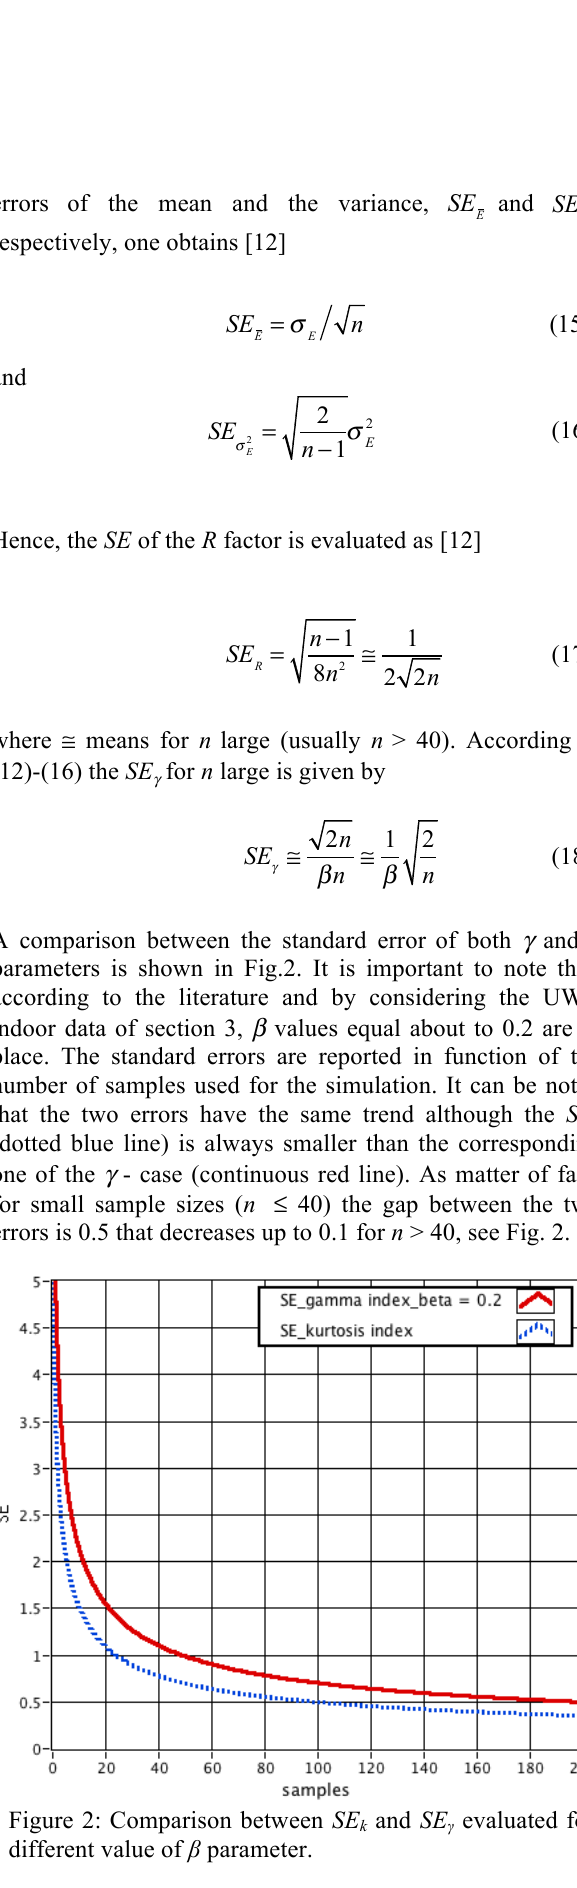
and SE evaluated for k γ